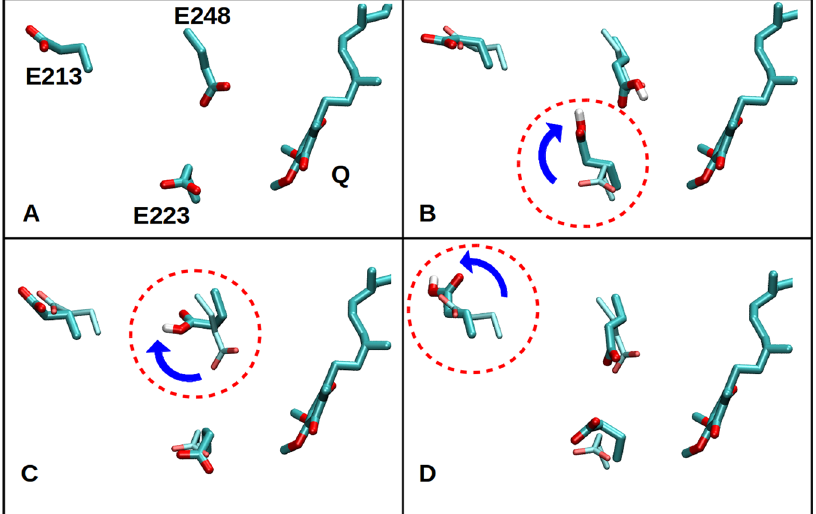
Figure 7. Flipping of amino acid side chains as observed in MD simulations. ( A ) A simulation snapshot (setup III in Table 1) shows QH 2 (hydrogens not shown) close to the deprotonated acidic residues Glu248 and Glu223. Protonation of acidic residues (upon QH 2 oxidation) results in flipping of the side chains of protonated Glu223 ( B ), protonated Glu248 ( C ), and protonated Glu213 ( D ) in simulations setups VI, VII and IV, respectively (see also Table 1). The QH 2 molecule position is same in all panels, and is based on setup III